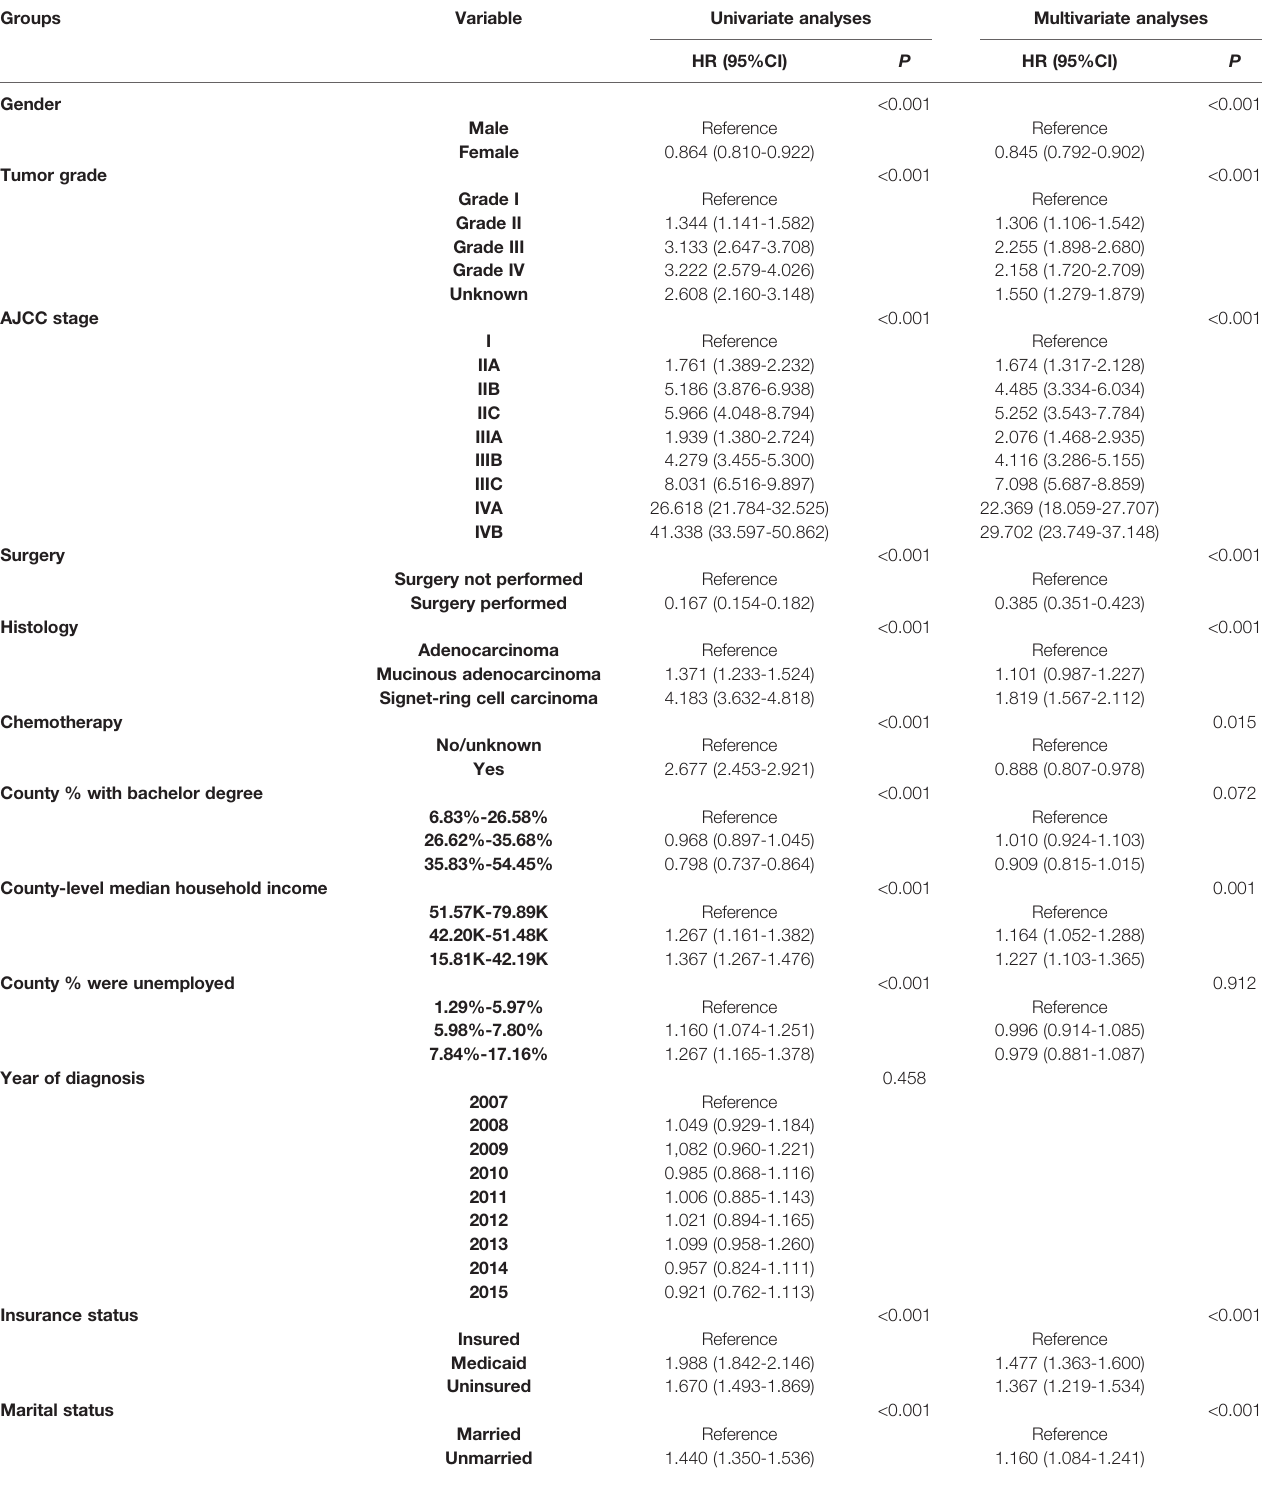
TABLE 2 | Univariate and multivariable Cox regression analyses of all independent prognostic factors in patients before the recommended initiating colorectal cancer screening